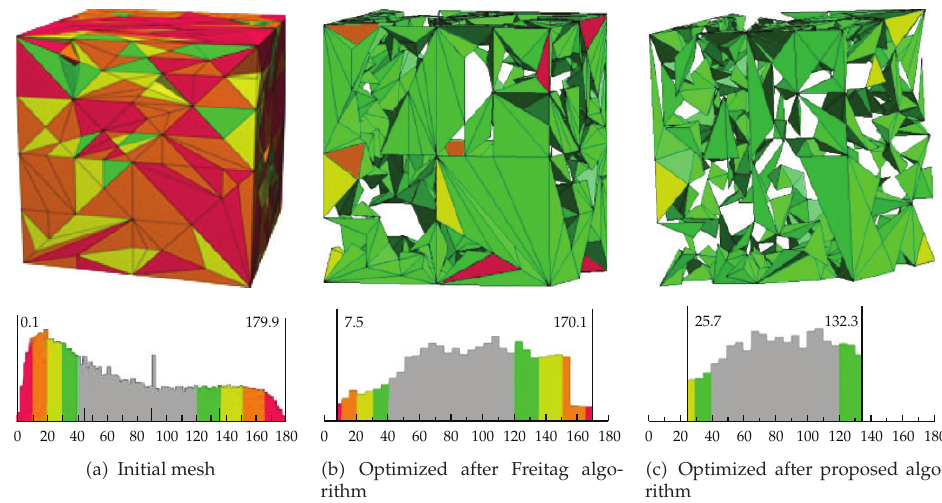
Figure 8: Mesh quality improvement for RAND2 with two algorithms.